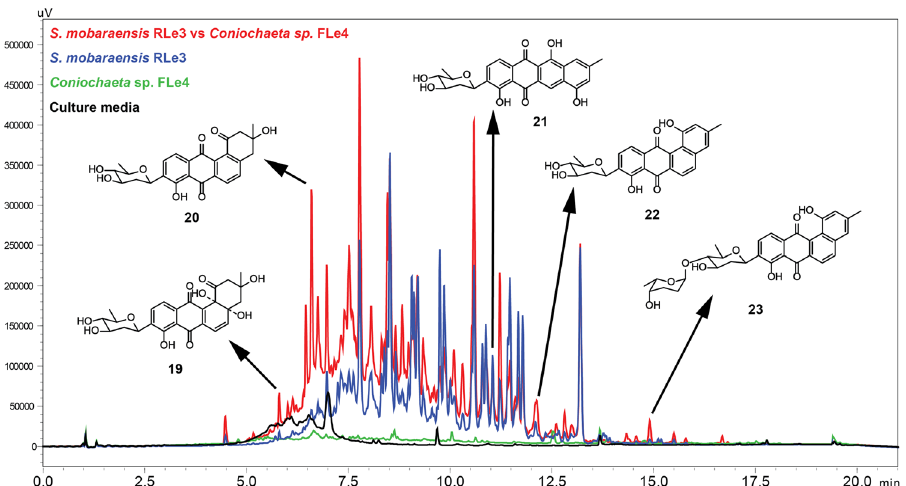
Figure 5. HPLC-DAD profile of extracts from microbial interaction between S . mobaraensis RLe3 and Coniochaeta sp. FLe4 in liquid culture. Overlaid chromatograms at 225 nm from culture media (black), S . mobaraensis RLe3 (blue), Coniochaeta sp. FLe4 (green), co-culture between RLe3 and FLe4 (red). Chemical structures from angucycline-derivatives isolated in this study. Urdamycinone B ( 20 ) is a representative metabolite overproduced by S . mobaraensis RLe3 during co-culture with Coniochaeta sp. FLe4 in liquid